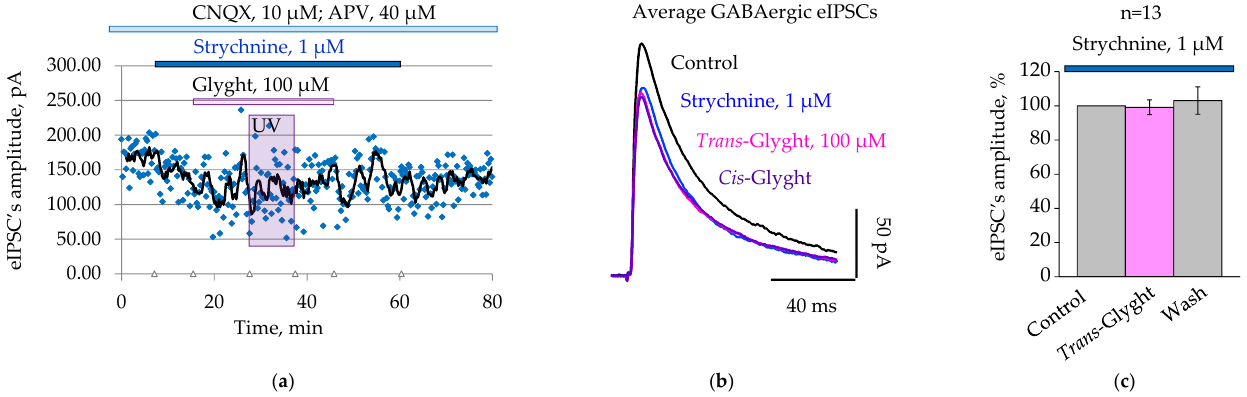
Figure 5. Glyght (100 µM) did not affect GABAergic transmission after application of strychnine: ( a ) the original eIPSCs’ amplitude values are continuously displayed on the scatter plot with a 5- period moving-average trendline (black line): note the absence of an additional decrease in amplitude of GABAergic eIPSCs after administration of Glyght in both cis - and trans -configurations; ( b ) super- imposed traces of average GABAergic eIPSCs ( n = 9 – 20) recorded in control ACSF, after application of strychnine, Glyght and after washing; ( c ) summary results of the normalized mean amplitudes of eIPSCs after application of Glyght (100 µM) and subsequent washing, whereas strychnine was routinely added to solutions (mean percent ± SEM; n = 13; P6 – P8).